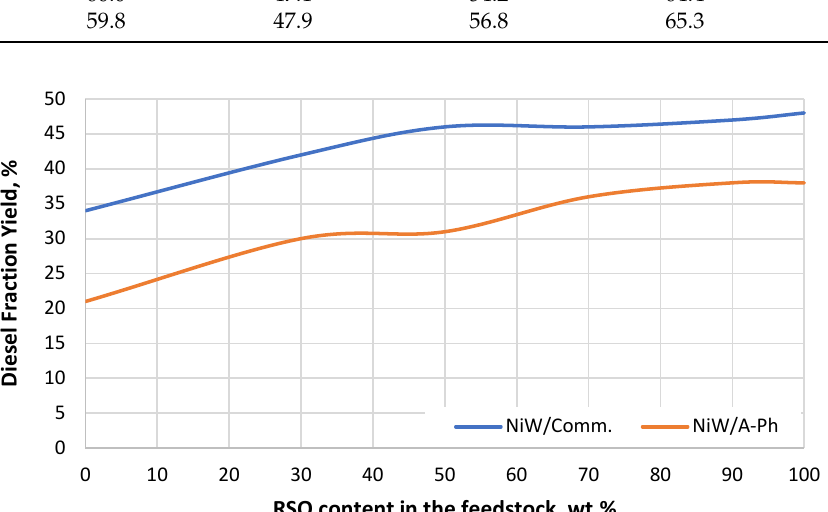
Figure 7. Diesel fraction yield gained throughout the experiment using both tested NiW catalysts (NiW/A ‐ Ph, NiW/Comm.) depending on the RSO content in the processed feedstock blend.